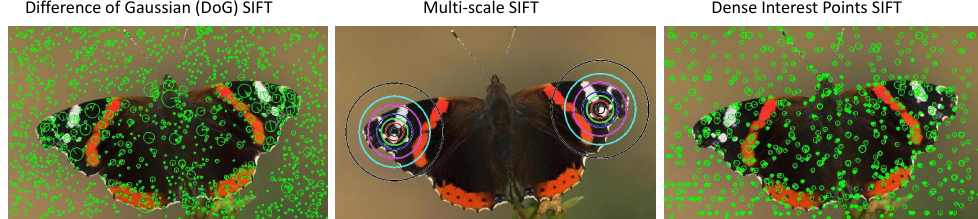
Figure 8. Comparisons of the different strategies employed for SIFT features extraction for traditional classification